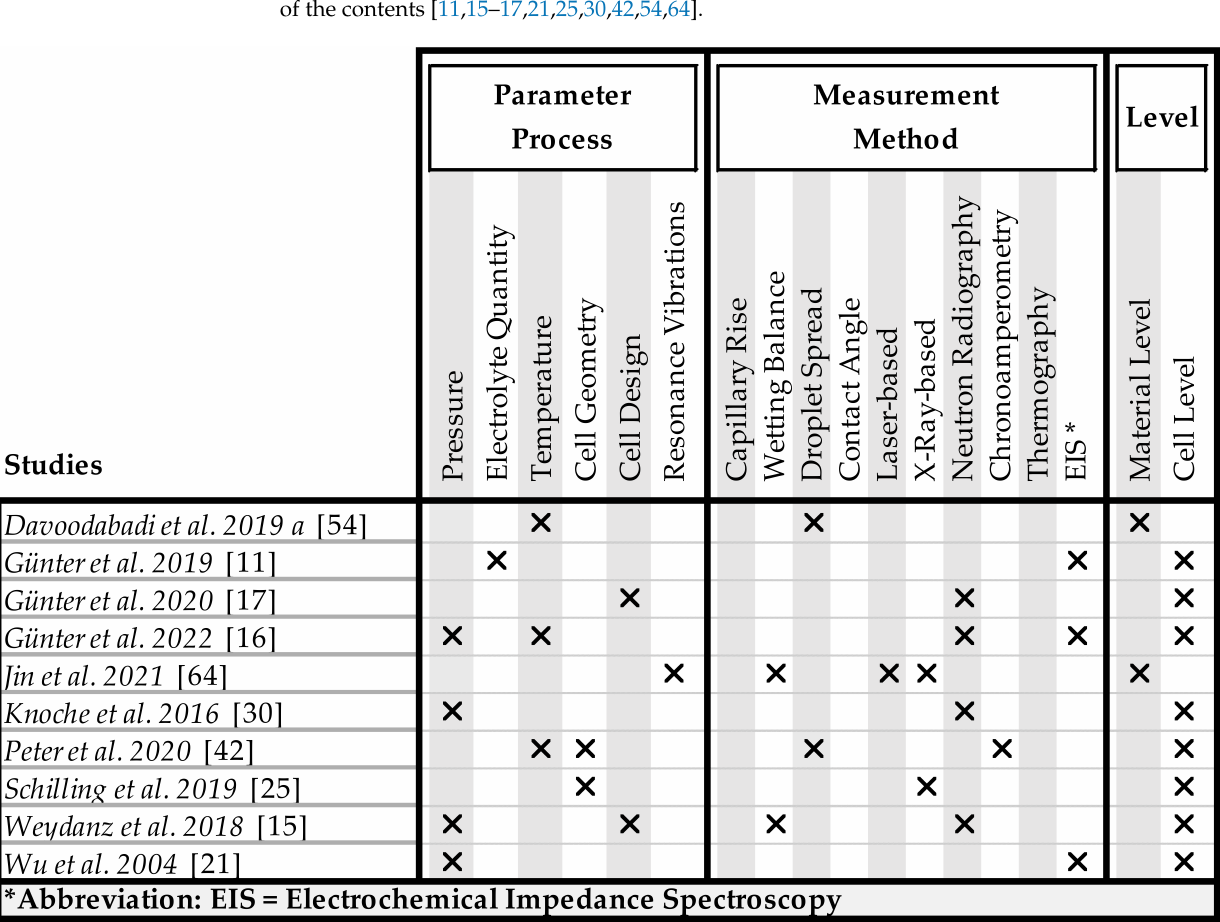
Table 2. Overview of the publications assigned to the Process Parameters category with a